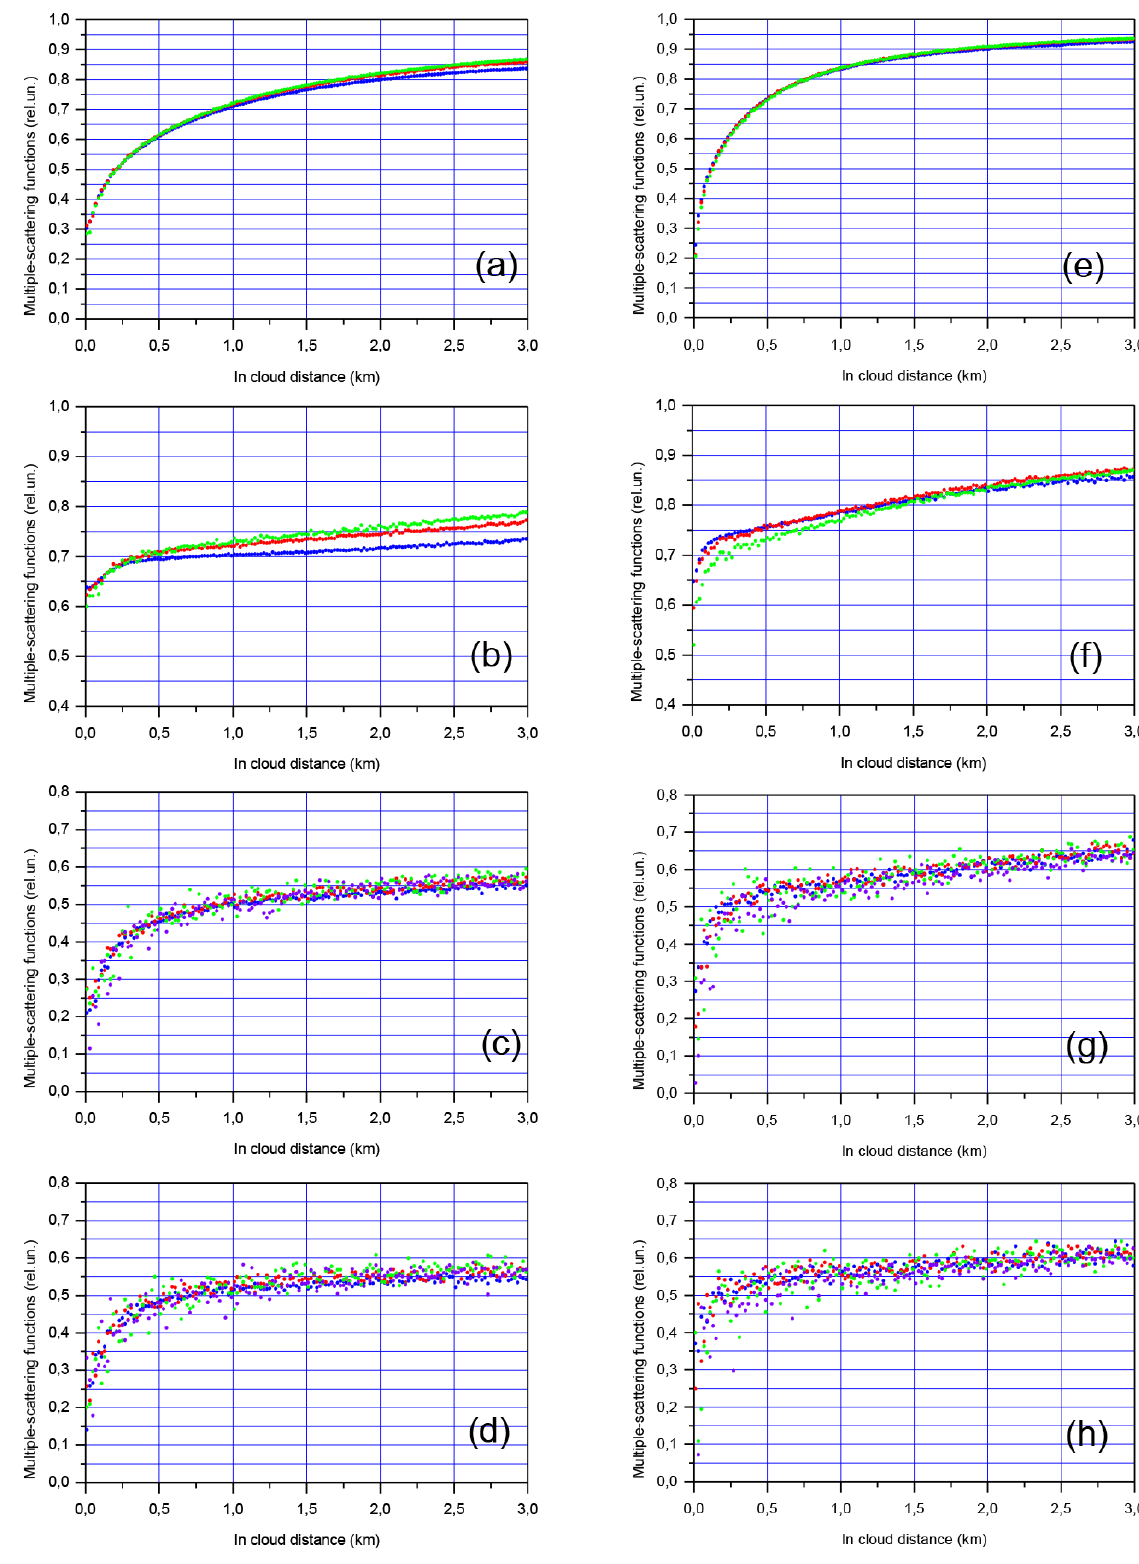
Figure 8. MC simulations of multiple-scattering functions η MS (d) . The CALIOP configuration (a–d) and the ATLID configuration (e–h) . Coarse aerosol (a, e) , water cloud (b, f) , JS cirrus (c, g) , Ci cirrus (d, h) . The extinction coefficient is 1.0km − 1 (blue points), 0.5km − 1 (red points), 0.2km − 1 (green points), and 0.06km − 1 (purple